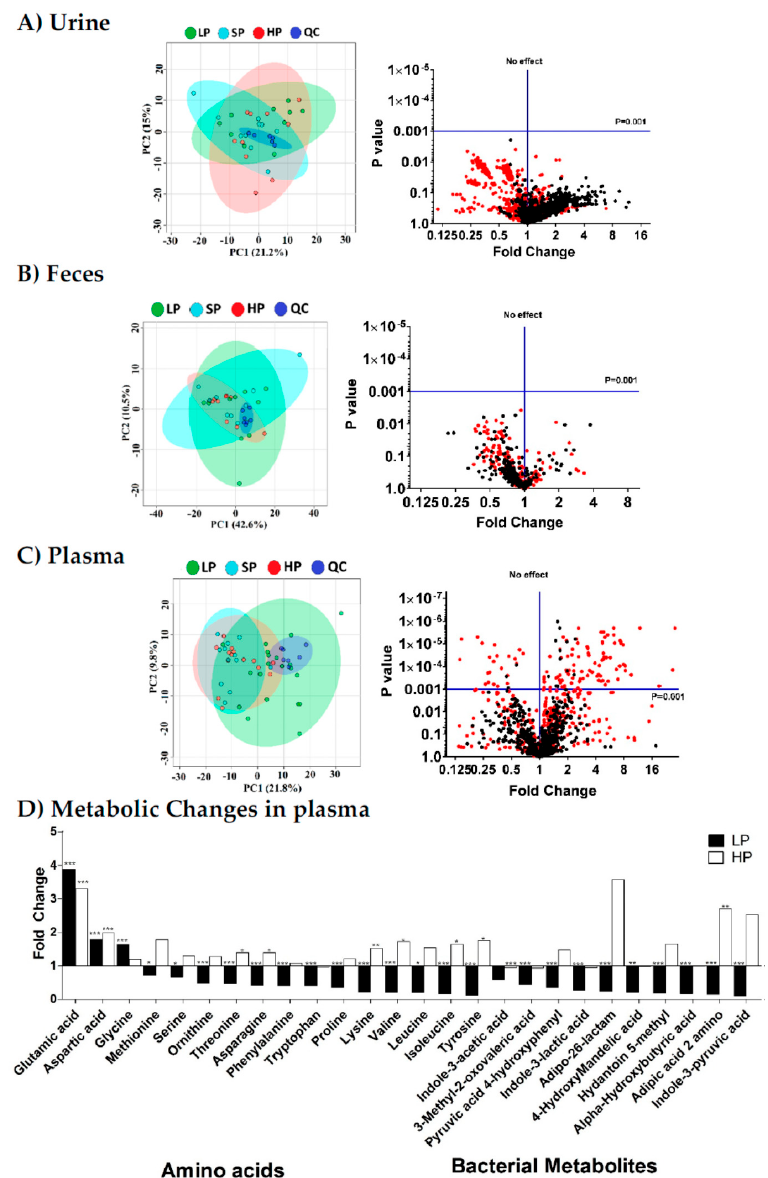
Figure 1. Metabolomic profiles of ( A ) urine, ( B ) faeces, and ( C ) plasma samples of wt mice on diets with low (LP—green), standard (SP—light blue), or high (HP—red) protein content (panels on the left). To synchronize the nutritional states of the mice, plasma samples were collected in the re-fed state, i.e., mice held for 14 days on the specified diet were fasted for 6 h and then re-fed with the same diet for 1 h before sample collection. Using standard settings, principal component analysis (PCA) could not discriminate between the three conditions. The quality control (QC) (dark blue) samples appear as tight clusters. The panels on the right side show the volcano plots constructed from all mass features in which the x-axis represents fold-change and the y-axis represents significance ( p -value). The plot shows the log-converted fold-change of metabolites between the LP and SP groups as red dots and between the HP and SP groups as black dots in ( A ) urine, ( B ) faeces, and ( C ) plasma samples of wt mice. The horizontal blue line represents the statistical significance cutoff, and the vertical blue line represents no change. ( D ) Amino acid and bacterial metabolite changes in plasma. Fold-changes in LP (black) and HP (white) groups are compared to the SP group. Statistical significance is presented as follows: * for p -values between 0.05 and 0.01; ** for p -values between 0.01 and 0.001; *** for p -values < 0.001 ( n = 10 per